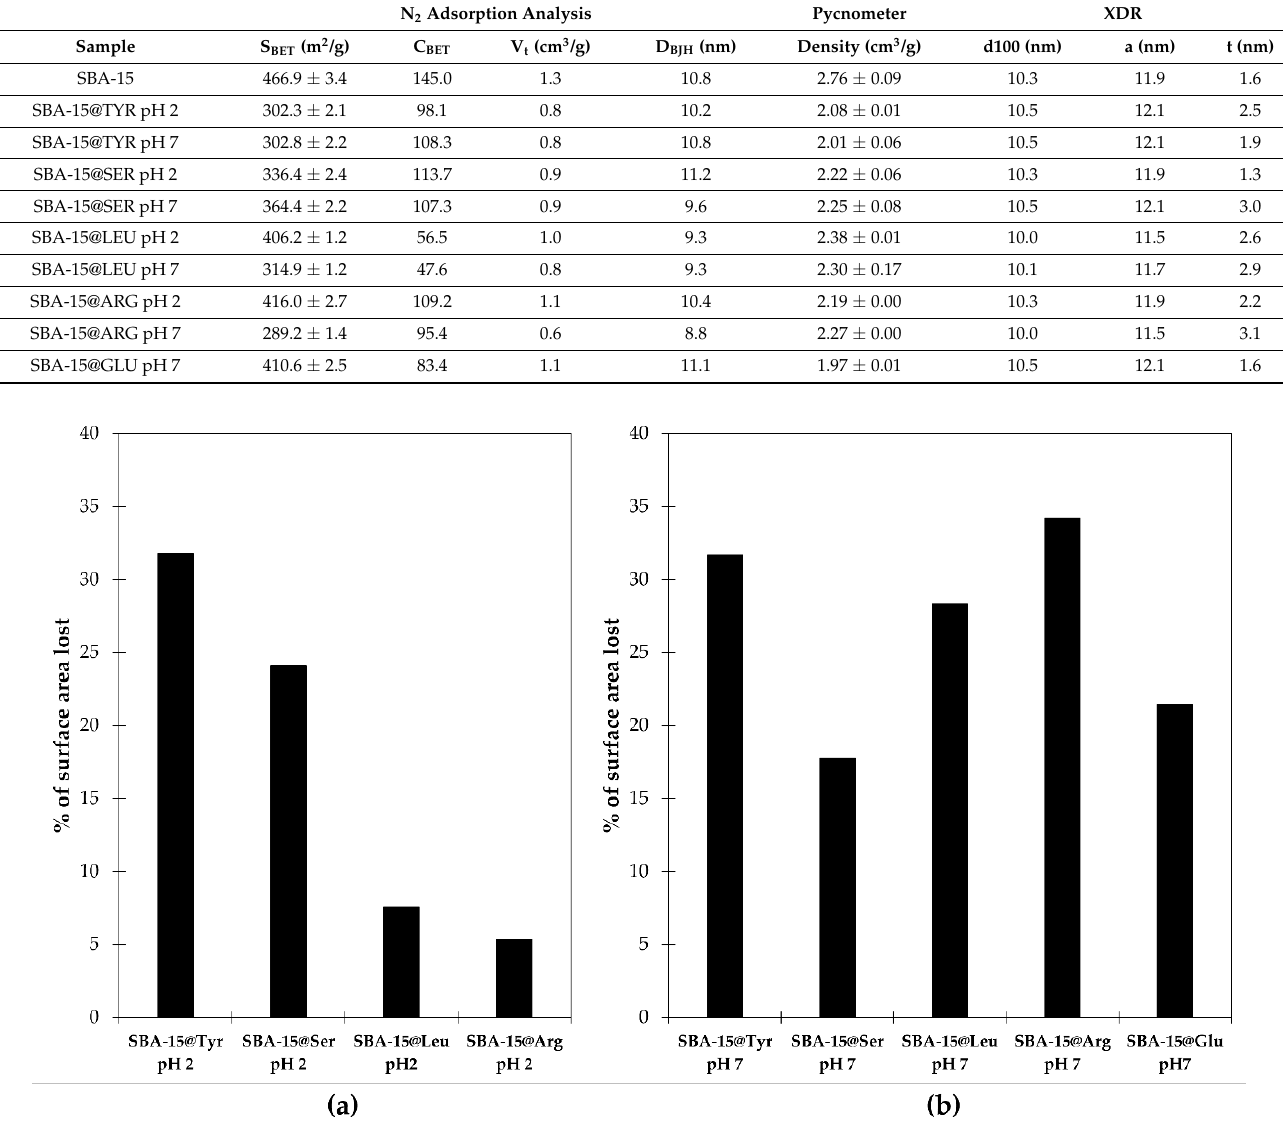
Figure 7. Percentage of surface lost for each material after the grafting step at pH2 ( a ) and at pH7 ( b ).